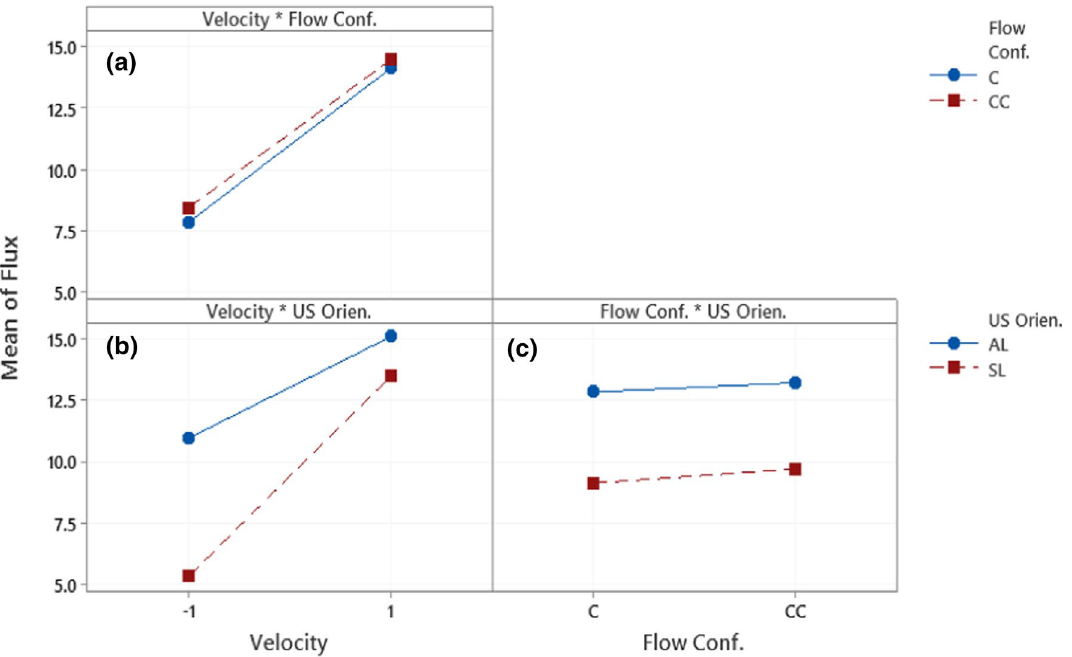
Fig. 3 Plots of the interaction effects of a CFV with flow configuration, b CFV with ultrasound orientation, and c flow configuration with ultra- sound orientation on the water flux (L/m 2 ·h) for NaCl